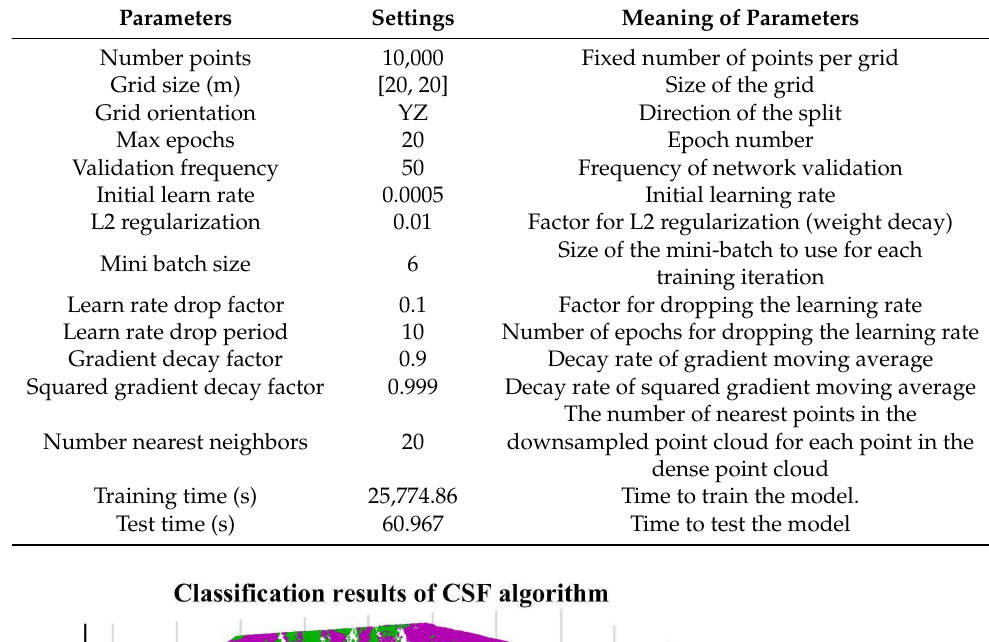
Table 6. Parameter settings for PointNet++.